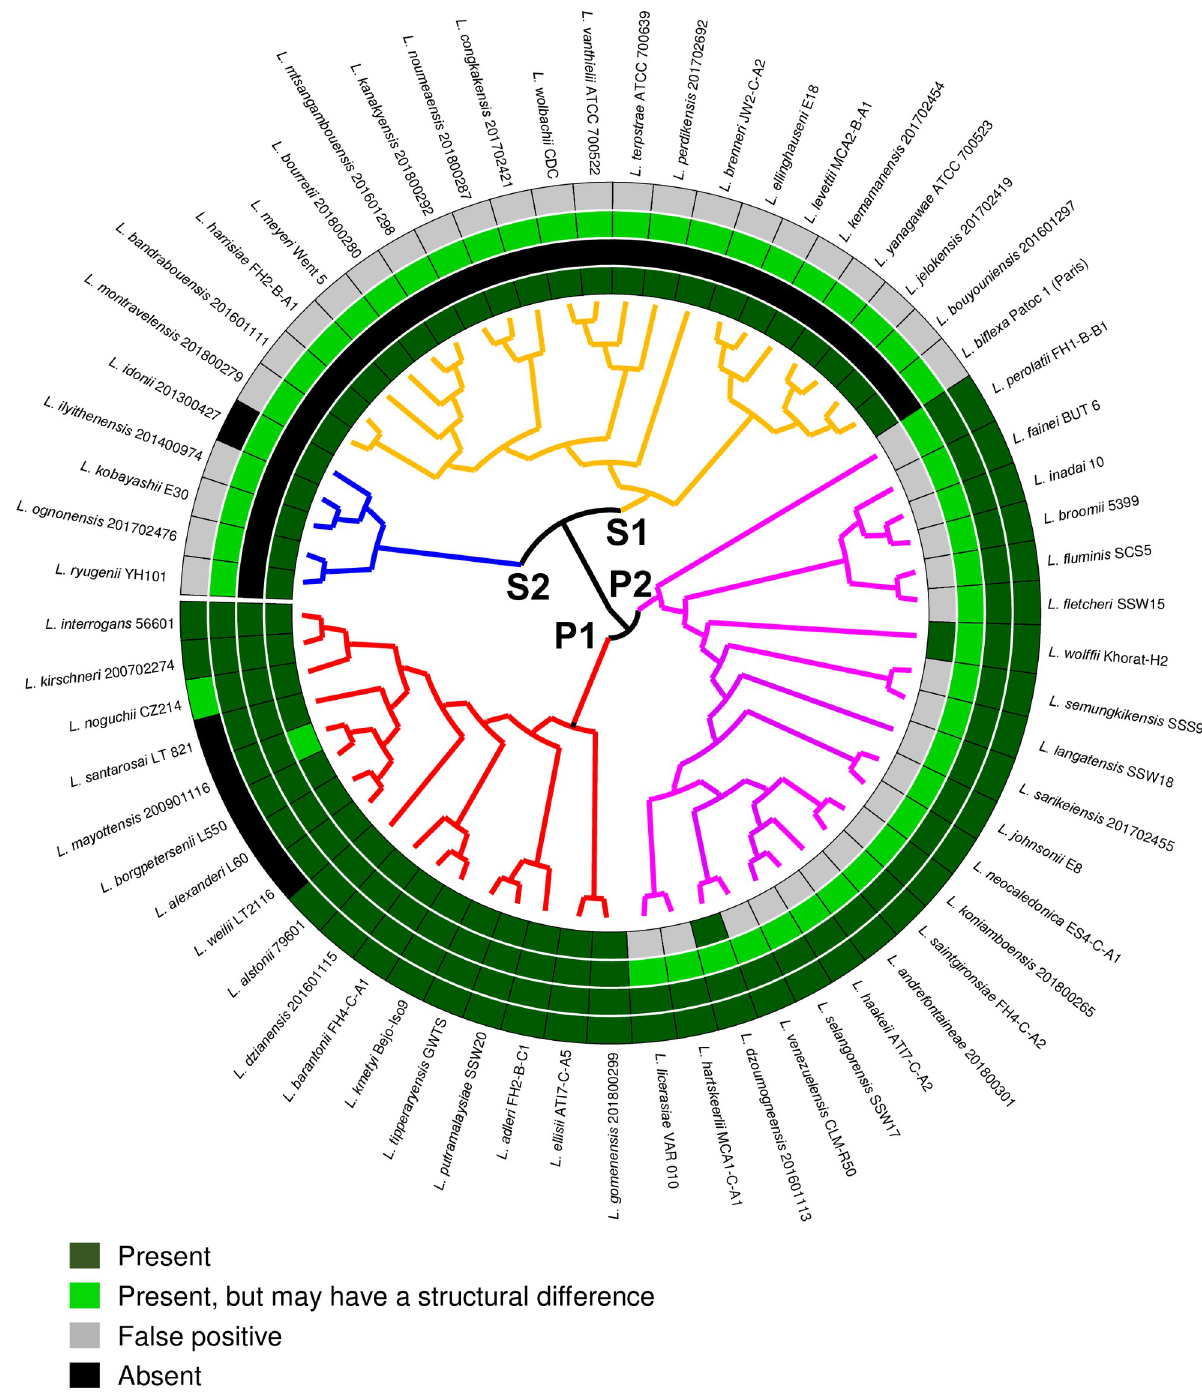
Fig 3. Distribution of the four Fur-like regulators of L . interrogans in the genus Leptospira . Circular phylogenetic tree with inner circles indicating the homology between each Fur-like regulator of L . interrogans with the closest homolog among representative genomes of Leptospira species. The branches are colored according to their classification into the four main subclades with P1 (highly pathogenic) in red, P2 (intermediates) in magenta, S1 (saprophytes) in yellow and S2 (new clade saprophytes) in blue [58]. The inner circles are, from the inside to the outside, PerRA (LIMLP_10155), PerRB (LIMLP_05620), LIMLP_04825 and LIMLP_18590. The green color gradient indicates the degree of homology (See S1 Table). Grey indicates the presence of a false positive (a different fur-like regulator with low homology) and black indicates the absence of orthologs.